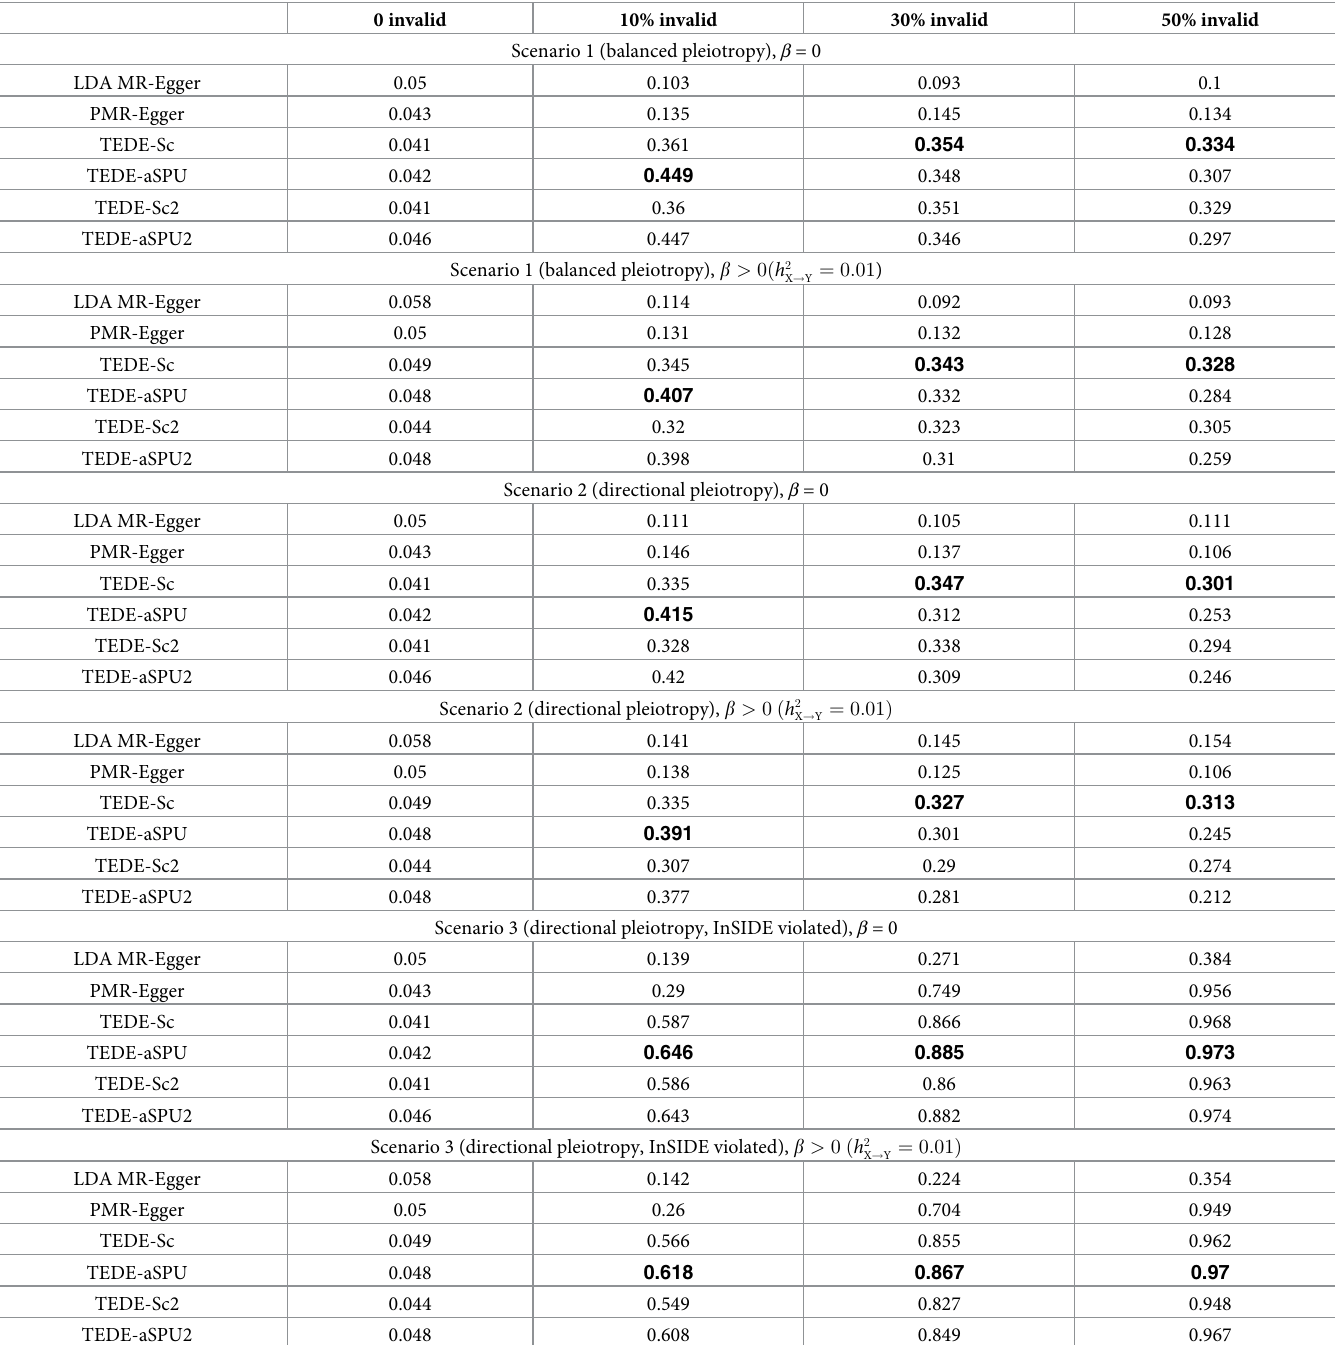
Table 3. Rejection rates (type I error when there is 0 invalid IV; power otherwise) for testing valid IV assumptions. 1000 iterations. p = 30. Low LD ( p = 0.3). 0 invalid 10%